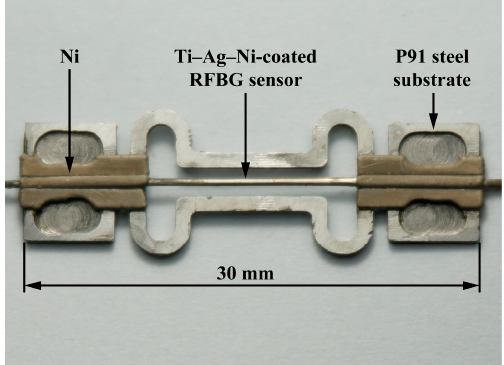
Figure 8. A laboratorial prototype of a metal-packaged strain sensor based on the RFBG in H 2 -loaded PS1250/1500 fiber.